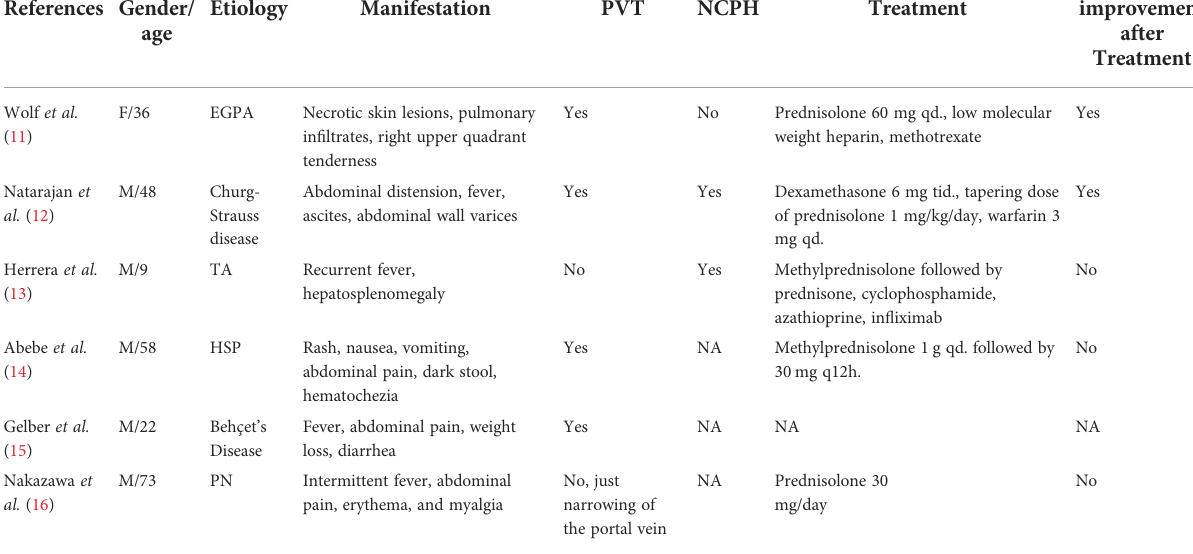
TABLE 1 The clinical characteristics of patients with NCPH or portal obstruction/stenosis caused by systemic vasculitis.